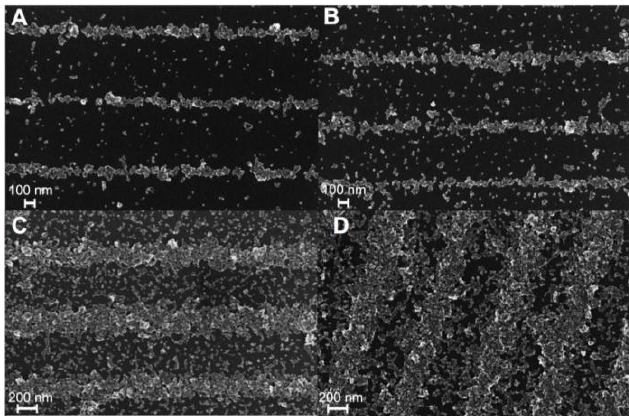
Figure 1. Scanning Electron Microscope (SEM) images of nanoparticle self-assembly onto perpendicular media recorded with 750 nm wide regions of alternating magnetization direction (up and down), for different coating times: ( A ) 5 min; ( B ) 15 min; ( C ) 30 min; and ( D ) 60 min. Note the significant change in width as a function of time as well as the assembly of material into the gaps with increasing